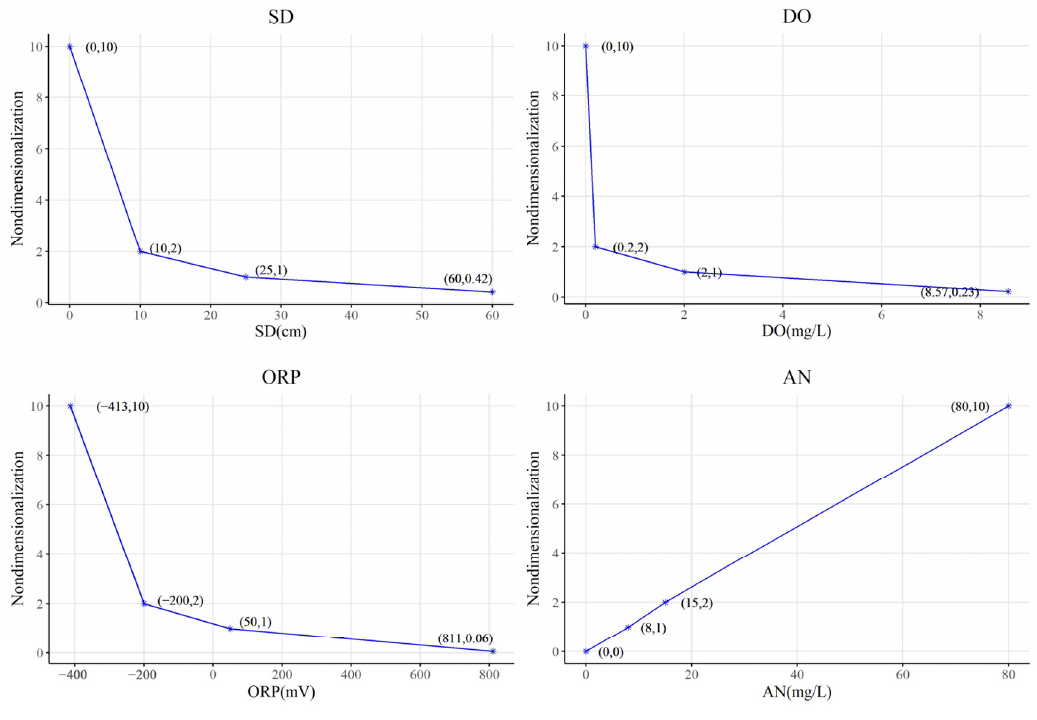
Figure 3. Dimensionless functions of SD, DO, ORP, AN.